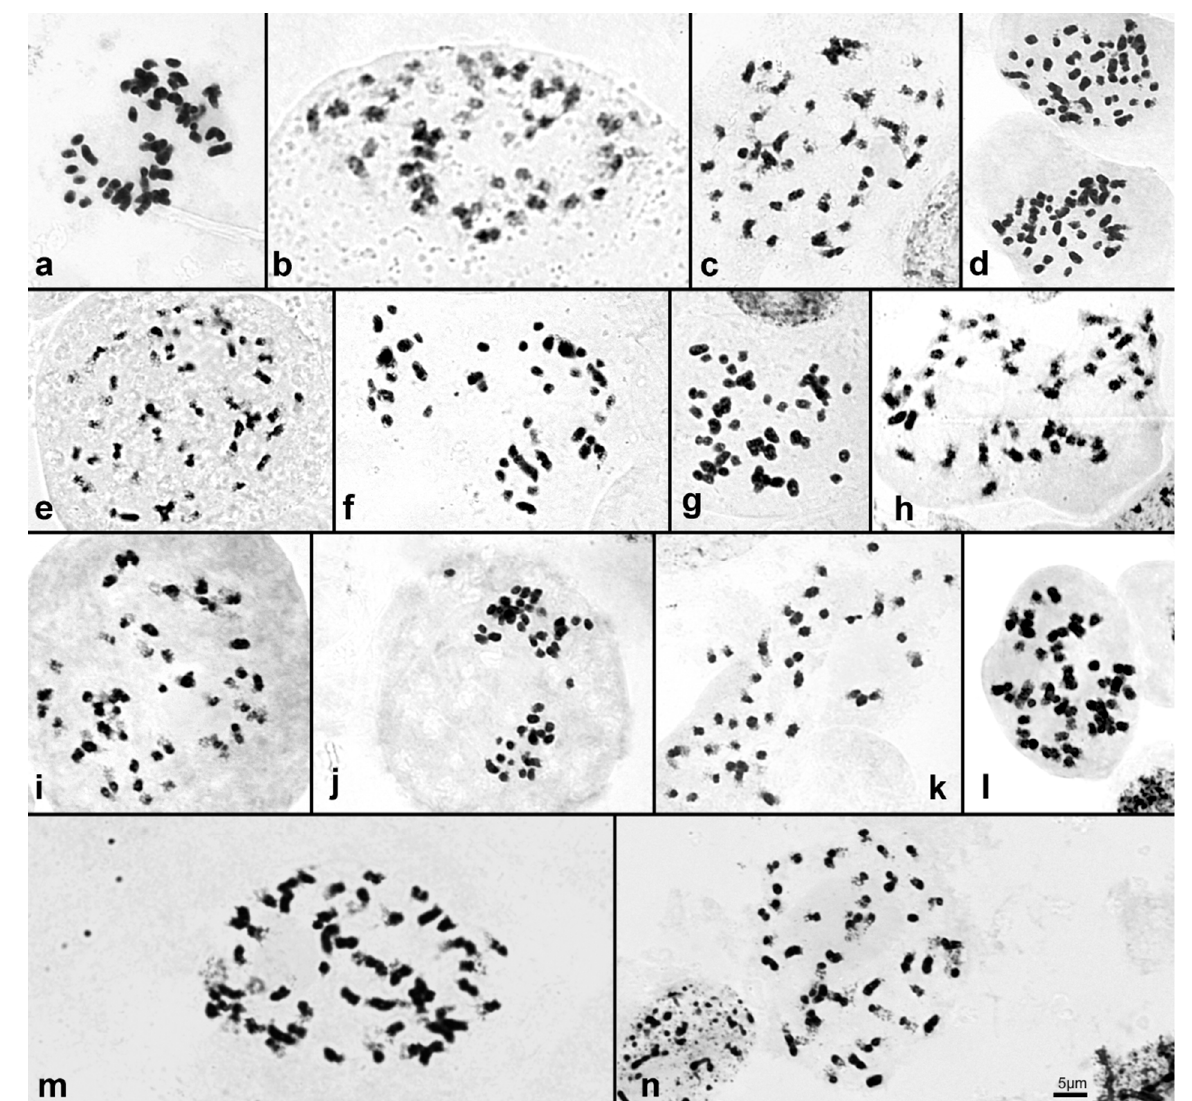
Figure 4. Chromosome complement of Sobralia species. ( a ) S. bimaculata (2 n = 44), ( b ) S. decora (2 n = 42), ( c) S. decora (2 n = 44), ( d ) S. fimbriata (2 n = 46), ( e ) S. macrantha (2 n = 48), ( f ) S. powelli (2 n = 44), ( g ) S. vallecaucana (2 n = 48), ( h ) S. wilsoniana (2 n = 48), (i) S. yauaperyensis (2 n = 46), ( j ) S. crocea (2 n = 44), ( k ) S. fragrans (2 n = 42), ( l ) S. gloriosa (2 n = 48), ( m ) S. luerorum (2 n = 48), ( n ) S. rosea (2 n = 48). Bar in h correspond to 5 µm. The DNA content was estimated for 20 species (six Brasolia , two Elleanthus, and 12 Sobralia ), ranging from 1C = 2.04 pg in E. crinipes to 1C = 8.05 pg in S. luerorum, reflecting a four-fold difference in genome size values (Table 1). According to the categorization proposed by Soltis et al. [16], three species can be considered as having small genomes (1C- value varying from 2.04 to 3.43 pg) and 17 as having intermediate genome sizes (1C-value varying from 3.77–8.05 pg; Table